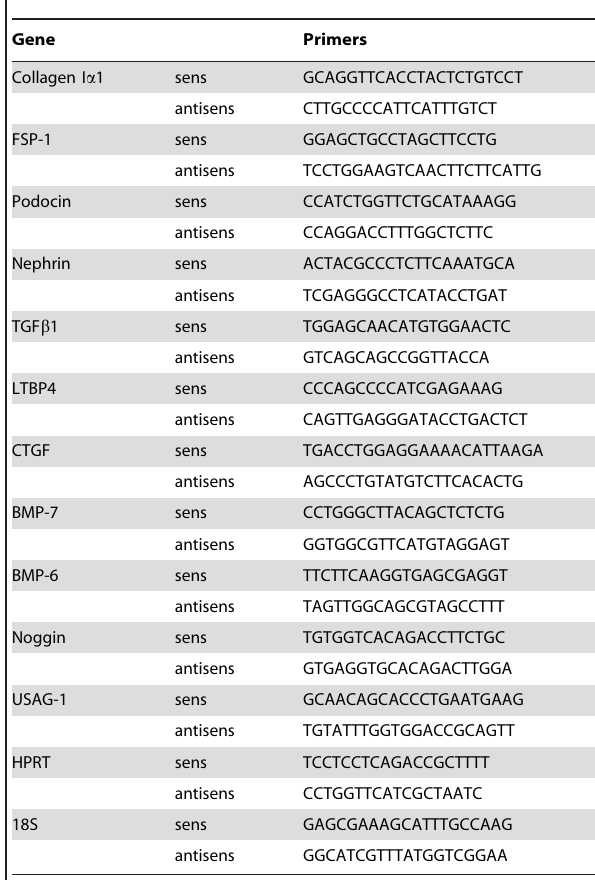
Table 1. List of the primers used for the Real Time-PCR of the different genes as mentioned in the results